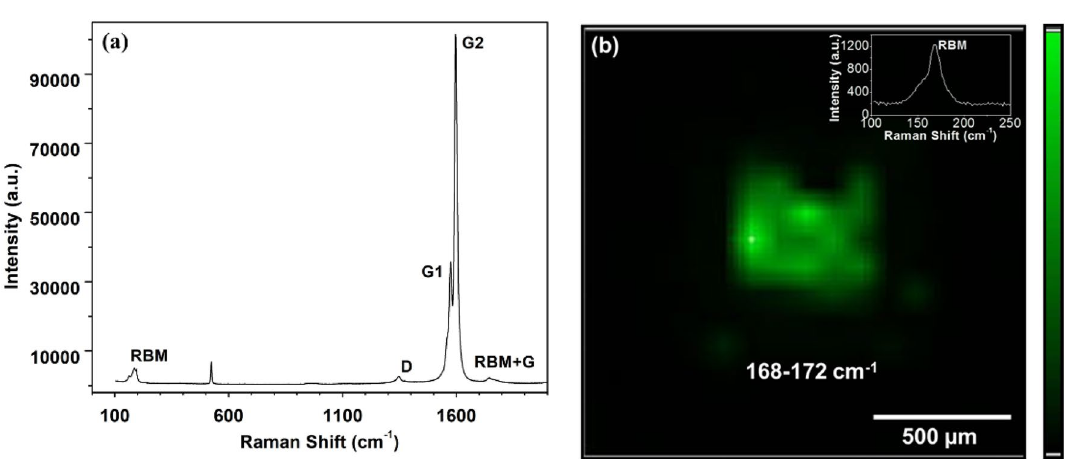
Figure 6. FESEM images ( a ) show the confined network of s-SWNTs between the electrodes ( source-drain) for individual devices ( b ) the enlarged portion (green box) in ( a ) shows the blurring effect, and ( c ) the enlarged portion (blue box) in ( b ) i.e. the outermost portion of the single device confirms the discontinuity in s-SWNTs film.